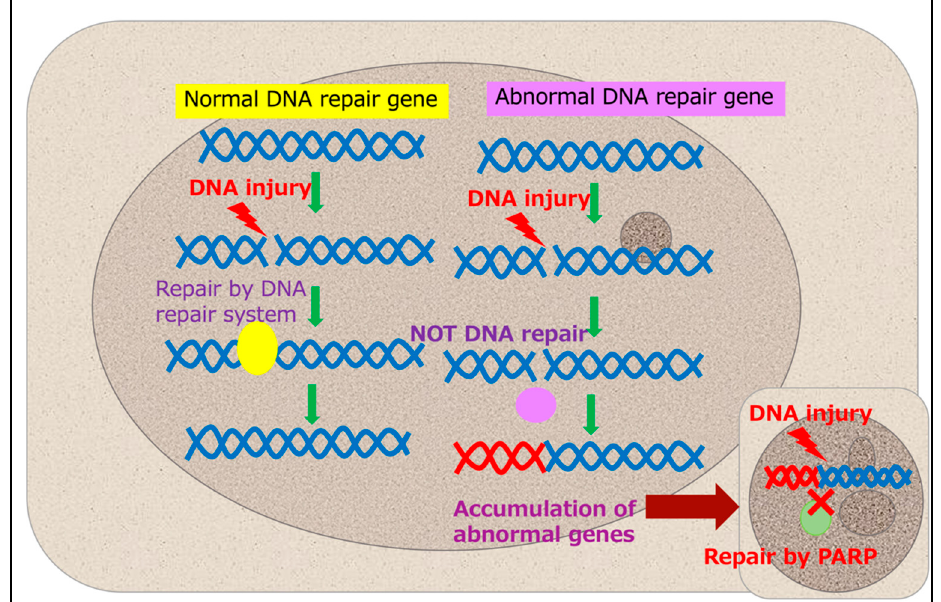
Figure 3. Accumulation of abnormal genes due to abnormal gene repair mechanisms. Abnormal genes accumulate as a result of impaired DNA repair function. PARP repairs the damage caused in these abnormal genes, resulting in an increase in the number of cancer cells with abnormal genes.